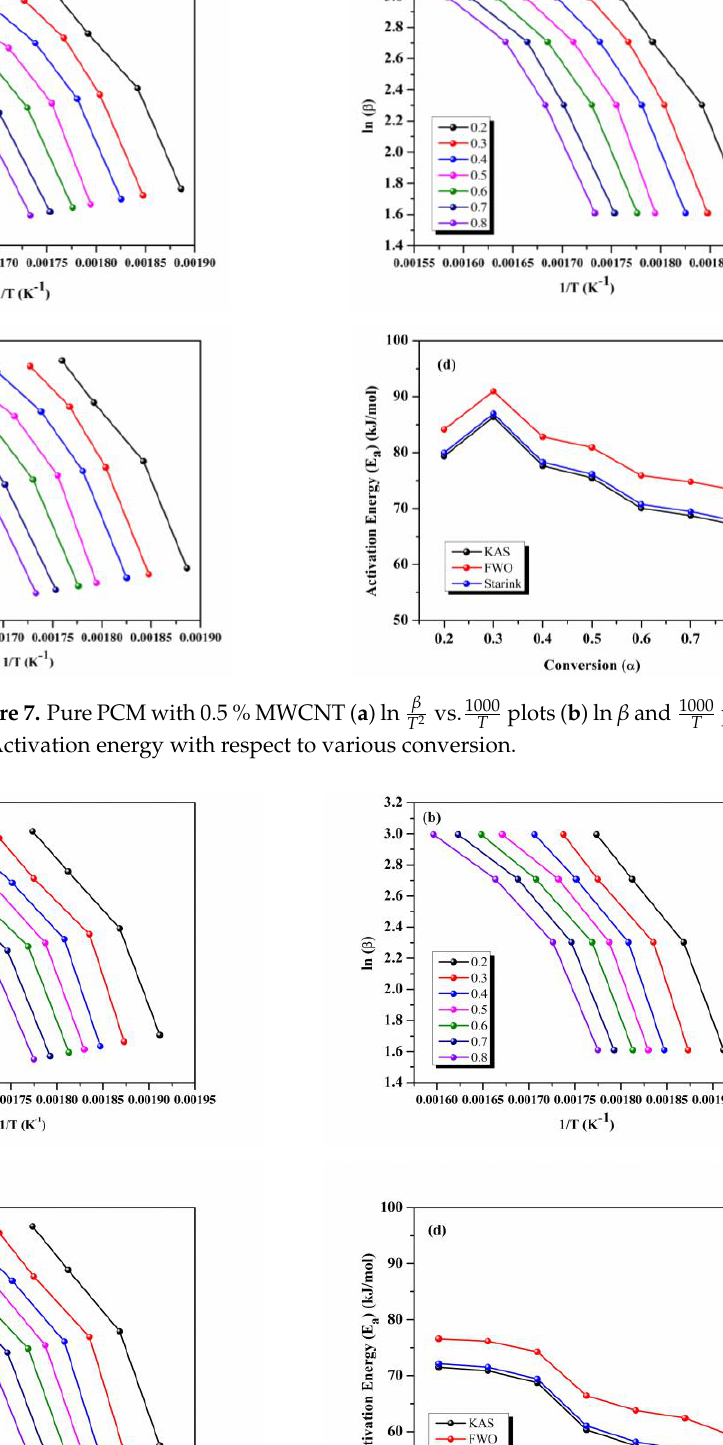
Figure 8. Pure PCM with 1% MWCNT ( a ) ln β ( d ) Activation energy with respect to various